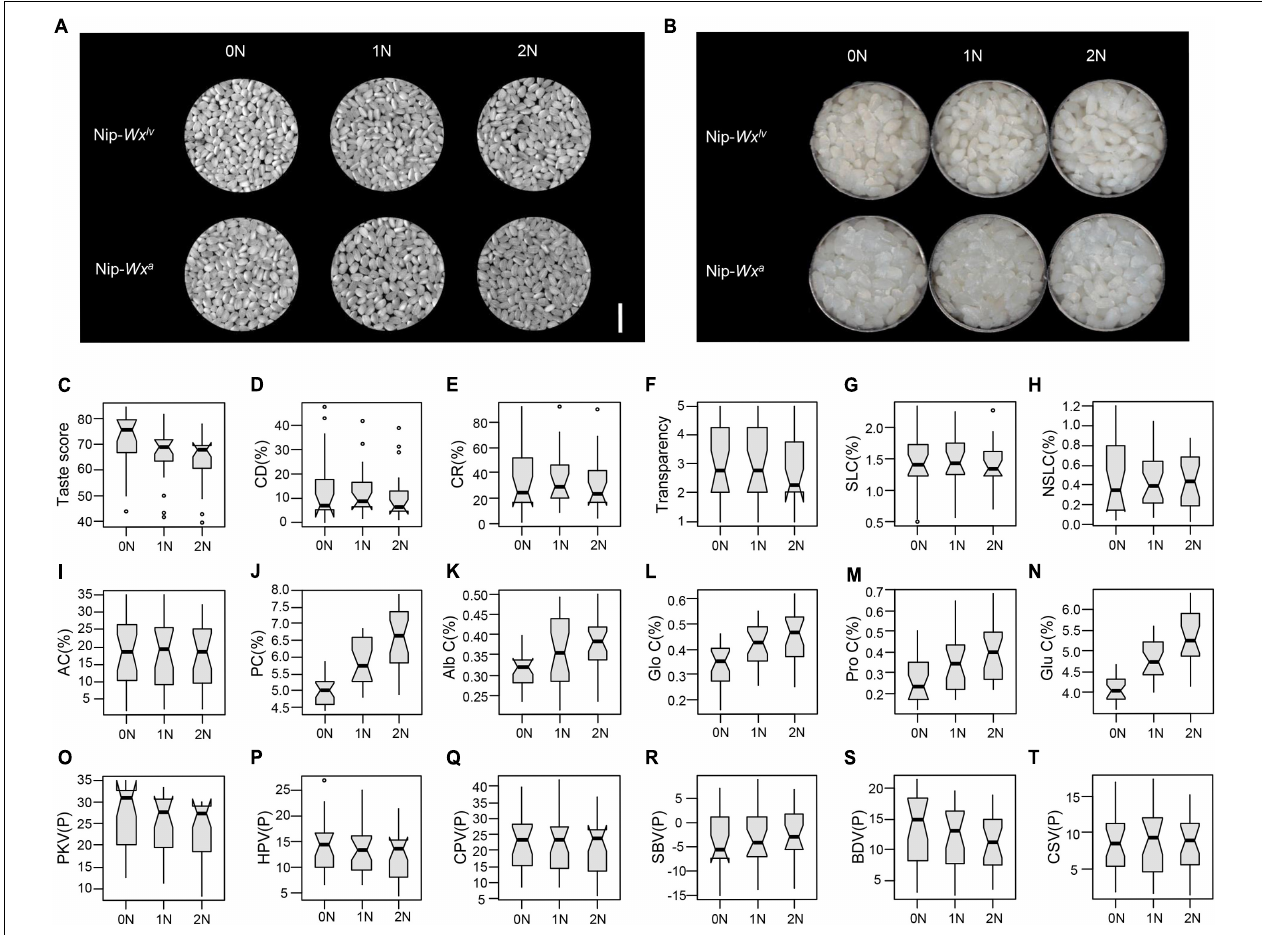
FIGURE 3 | Effects of nitrogen fertilization level on rice quality traits. (A,B) Grain appearance (A) and cooked rice appearance (B) of Nip- Wx lv and Nip- Wx a at different nitrogen fertilization levels. (C–T) The mean effects of nitrogen fertilization level on (C) taste score; (D) CD; (E) CR; (F) transparency; (G) SLCs; (H) NSLCs; (I) AC; (J) PC; (K) albumin content; (L) globulin content; (M) prolamin content; (N) glutelin content; and (O–T) viscosity